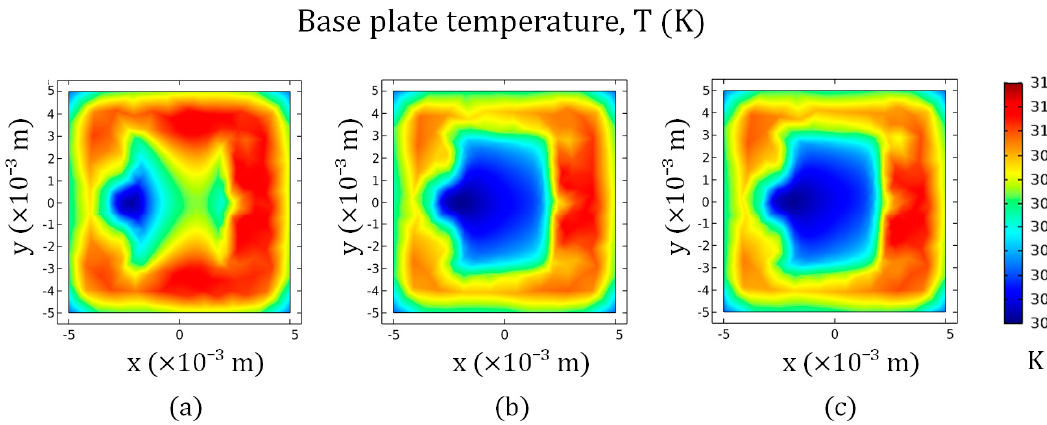
Figure 11. Temperature contour plot at the base plate of the heat sink at the volumetric flow rate of 4.0 × 10 − 6 m 3 / s for the ( a ) I-type conventional flow, ( b ) I-type regular trapezoidal secondary flow (heat sink A), and ( c ) I-type parallel secondary flow (heat sink B).